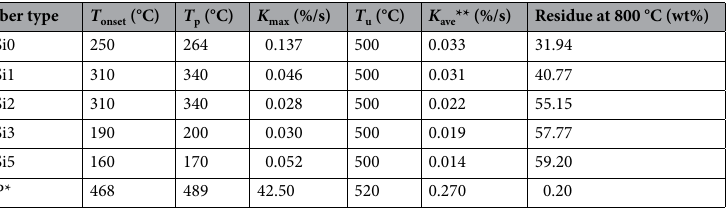
Table 4. Summary of the results from TGA for fungal fibers grown with Si source as well as for the synthetic PP fibers. *TGA results and residual weight of PP fibers are adapted from 32 . ** K ave , the average thermal degradation rate, is defined as the average mass loss rate per second in the range between T onset and T u .